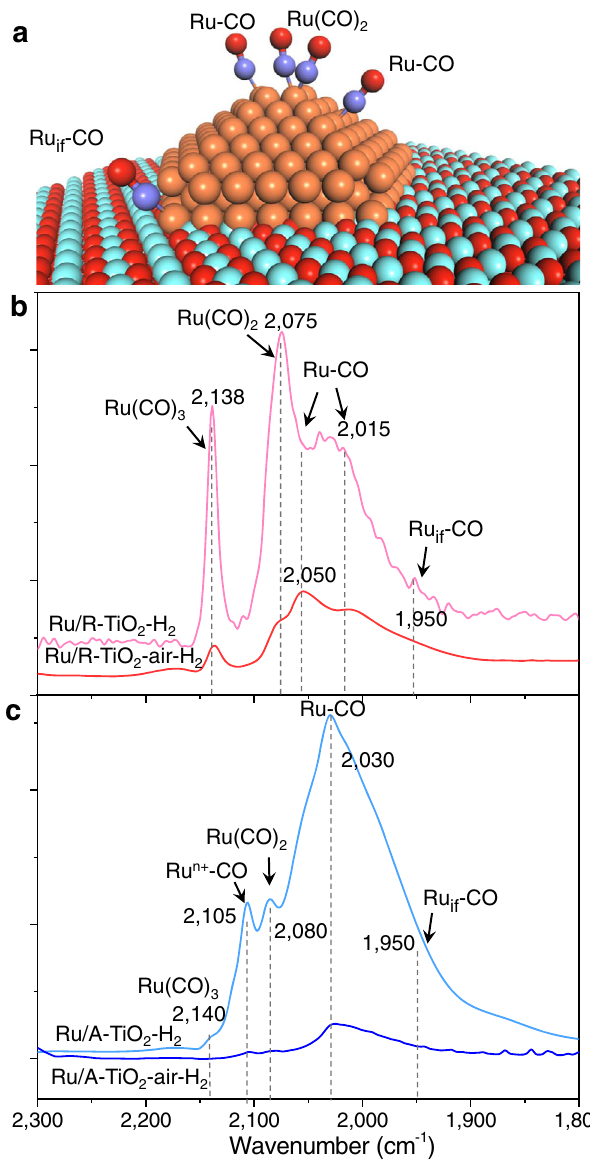
Fig. 4 Probing surface atomic states of Ru NPs with CO-DRIFTS at 25 °C. a Adsorption con fi gurations of CO on Ru/TiO 2 catalysts. b and c CO- DRIFTS of Ru/TiO 2 catalysts.